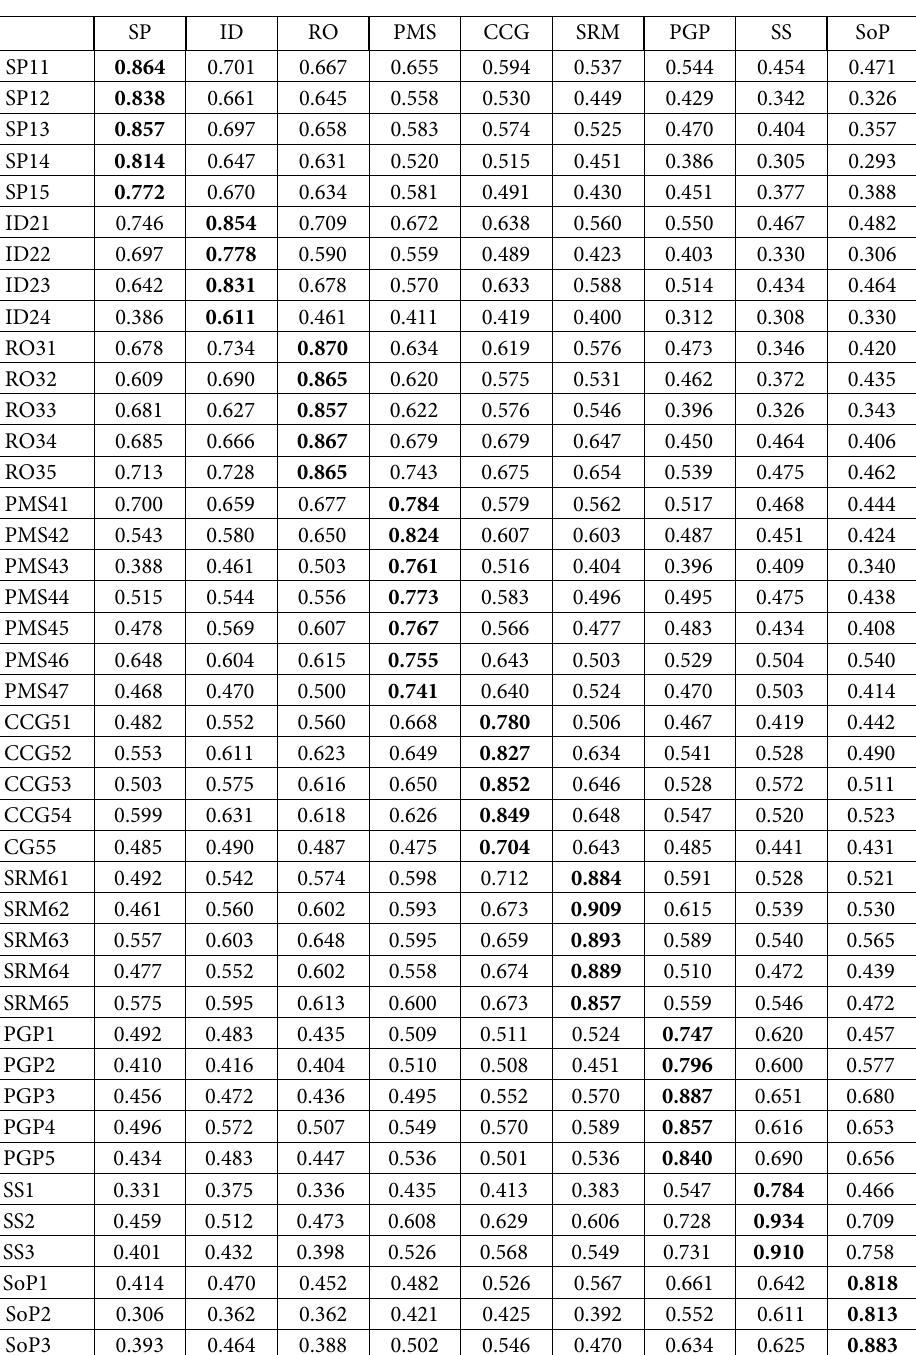
Table 9. Cross loadings for observed variables under different latent